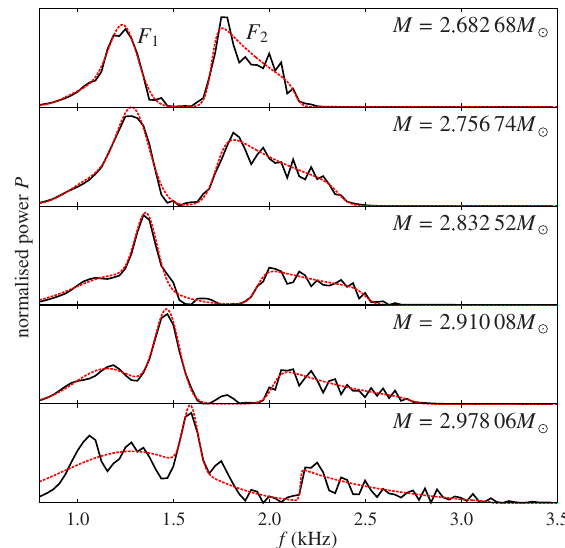
FIG. 2. The normalized power-spectrum reference templates [Eq. (1)] for each of the five system masses as a function of frequency (black lines). Also plotted are the best-fit model templates defined in Eq. (2) (red dashed